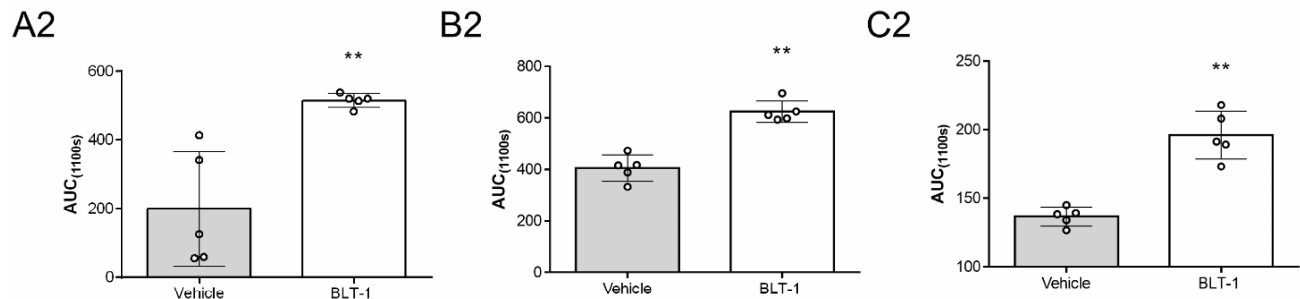
Figure 5. BLT-1 affects Ca ++ homeostasis in T. gondii , N. caninum and B. besnoiti tachyzoites. Vehicle- or BLT1-induced Ca ++ flux in and the related AUC data from Fluo-4-loaded T. gondii ( A1 , A2 ), N. caninum ( B1 , B2 ) and B. besnoiti ( C1 , C2 ) tachyzoites. Bars represent the means of five biological replicates ± standard deviation; ** p ≤ 0.01.